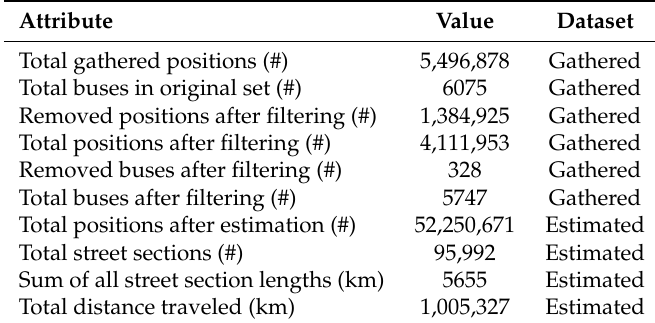
Table 2. Attributes of the gathered and estimated datasets.